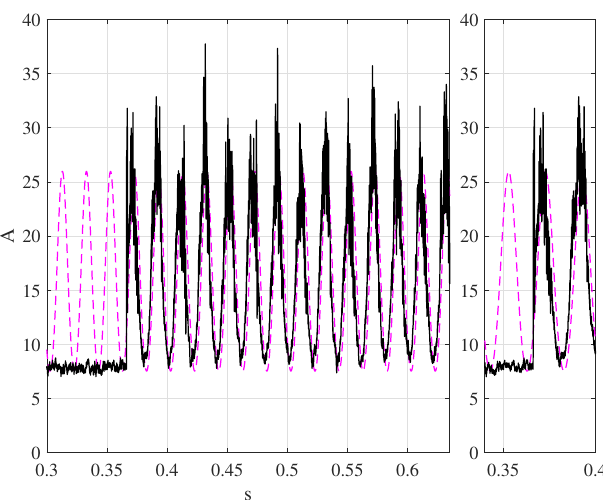
Figure 8. Output tracking of the inductor current with α = 314 (50 Hz). Reference signal in dashed line, and inductor current in solid line.